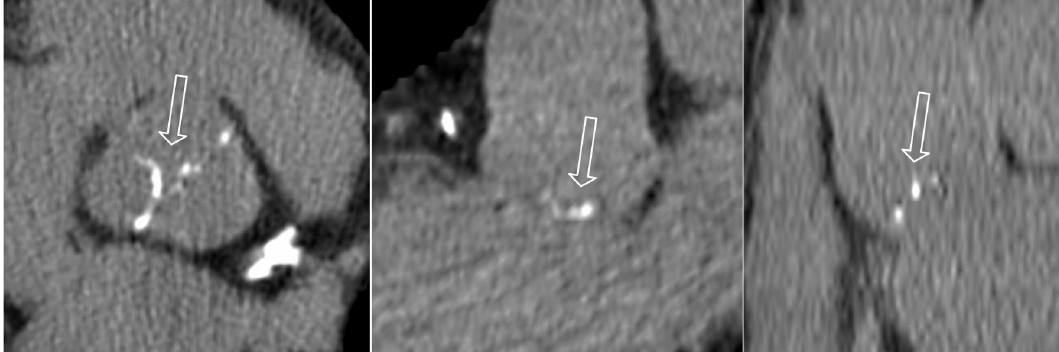
Fig 1. Computed tomography multiplanar refortmats in 3 orthogonal planes confirming the location of the aortic valve calcifications (arrows).